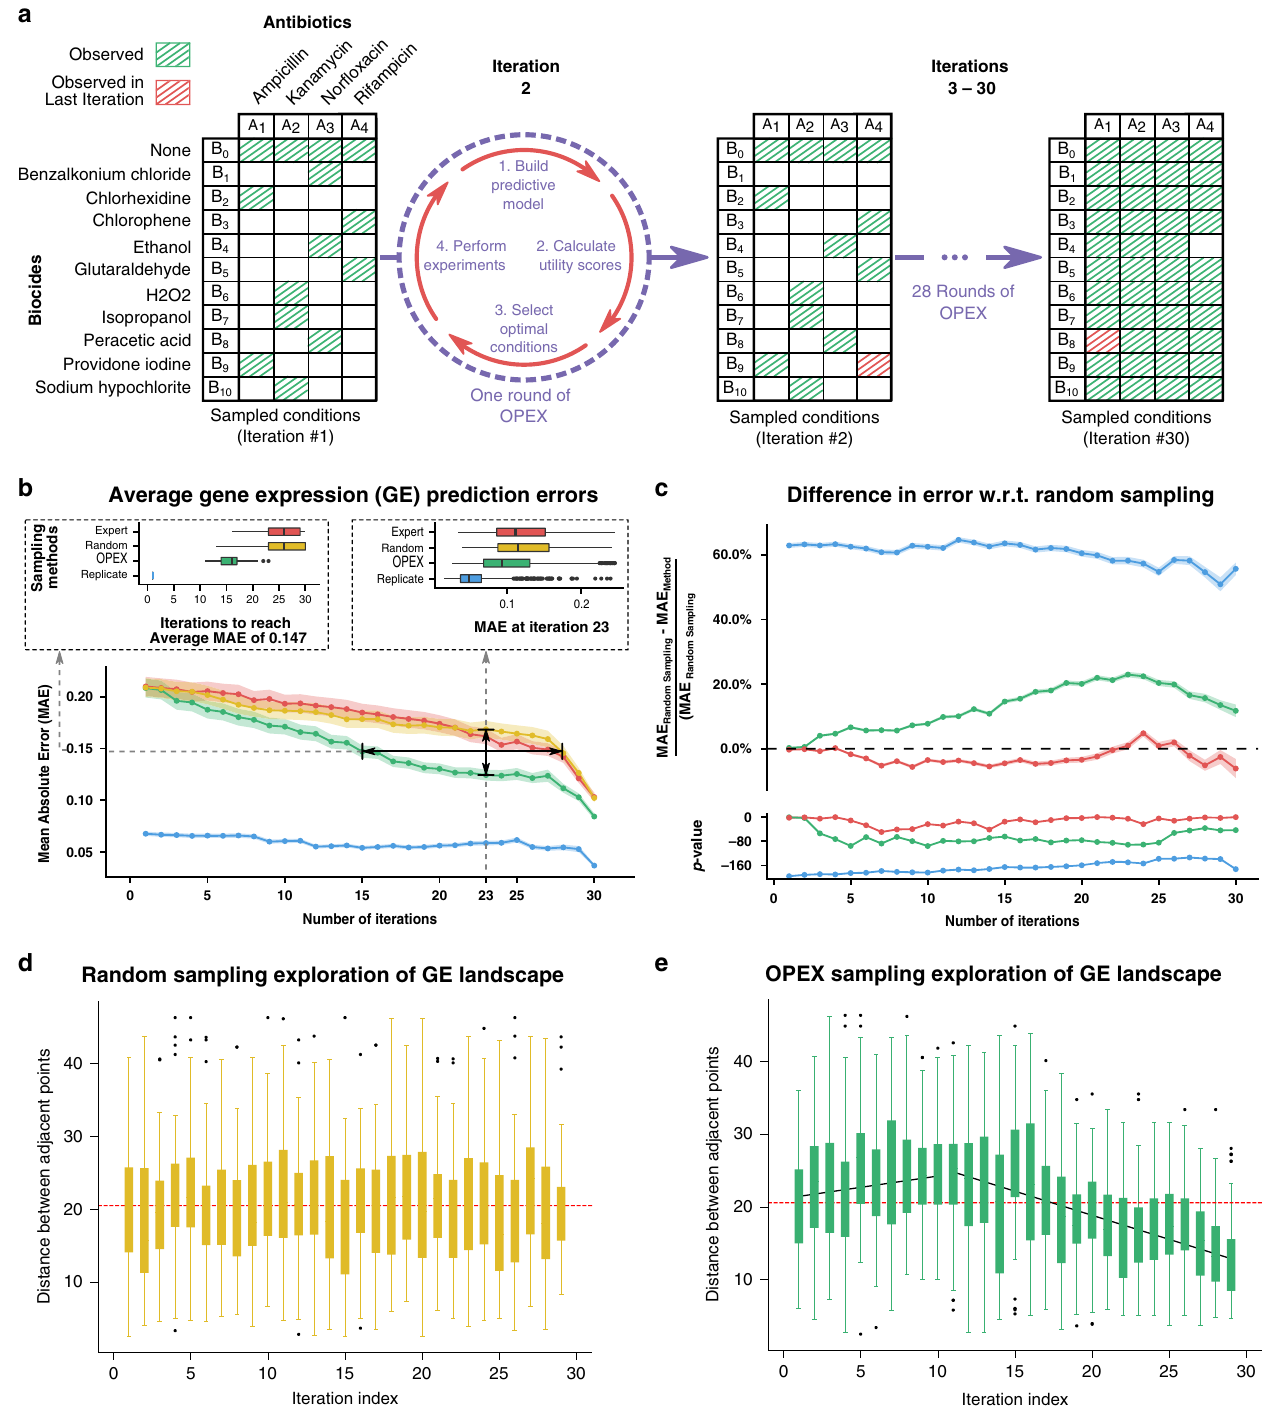
Fig. 2 OPEX applied to biocide – antibiotic experimental space. a After 15 randomly sampled initial conditions, we performed 30 iterations (rounds) of OPEX, where at each iteration, the genome-wide transcriptional pro fi le of E. coli is measured under a biocide – antibiotic combination. b Prediction error (MAE) for the remainder unobserved conditions at each iteration and for the three methodologies (Expert, Random, OPEX). Background envelop depicts the 95% con fi dence interval after 50 random initializations. Blue line depicts the variation in expression within the experimental replicates for each condition (three biological replicates). The boxplot on the top left shows the number of iterations necessary to reach a MAE of 0.15. The boxplot on the top right shows the MAE from each sampling method at iteration 23, where the gap between MAE of random sampling and OPEX is maximum. c The MAE difference and p value for each method with respect to random sampling. The p values were calculated by a one-sided paired t test ( n = 1123). d , e The distance between the gene expression pro fi les of every two consecutively selected culture conditions by random sampling and OPEX, respectively. Each box in the boxplot shows the average distance for 50 random initializations. The red dashed line shows the median of the distances over all the iterations. Each box represents an interquartile range, which consists of data points between the 25th and 75th percentiles. The whiskers extend to the maximum and minimum values but no further than 1.5 times the interquartile range for a given